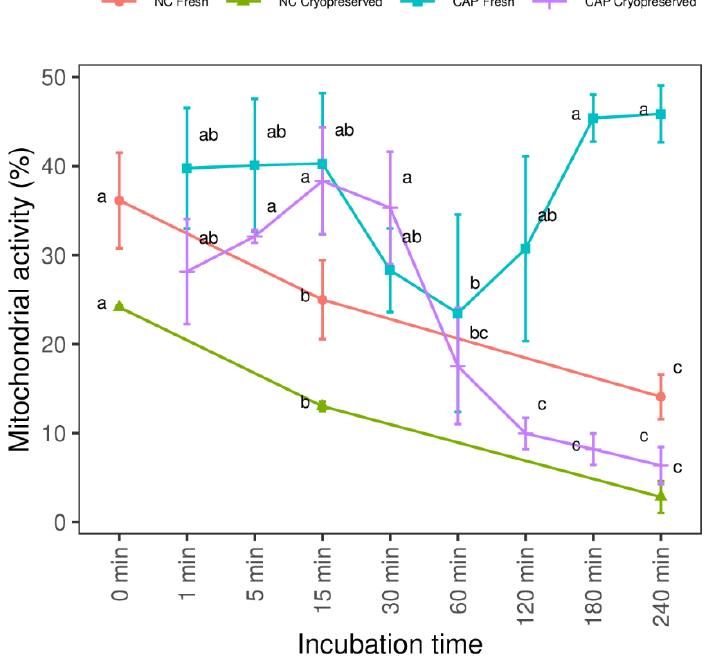
Figure 2. Mitochondrial activity of fresh and frozen-thawed spermatozoa incubated in capacitating (CAP) and non-capacitating (NC) media over time. Values showed the average proportion of live spermatozoa with active mitochondria (± S.E.M) in each time (n = 12 ejaculates, 4 rams × 3 replicates). Different letters denote substantial changes ( p < 0.05) among incubation times within each type of sample.